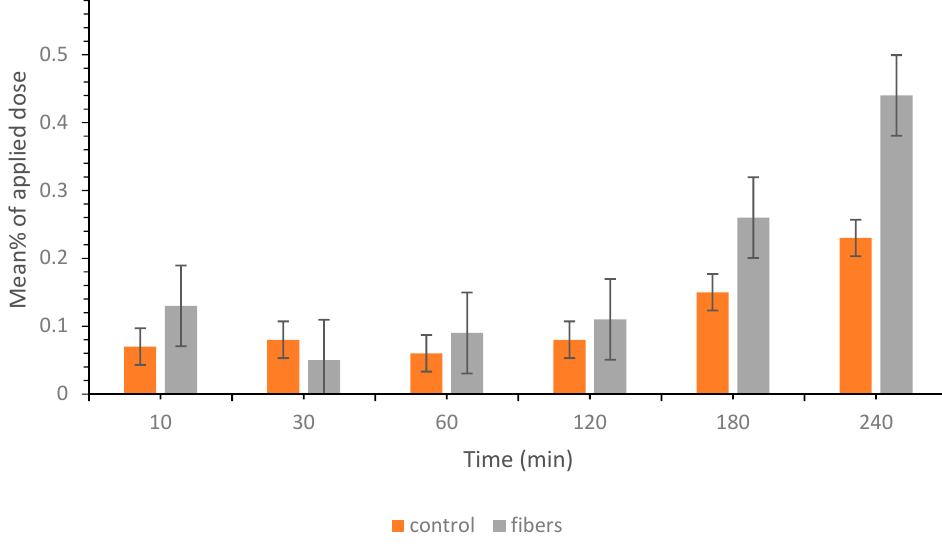
Figure 8. Ex vivo permeation data of QUE in bovine buccal mucosa showing the mean % of applied dose with respect to time. QUE in the fibers had an enhanced permeation starting from 60 min, up to 240 min; however, it was not significantly different ( p > 0.05).